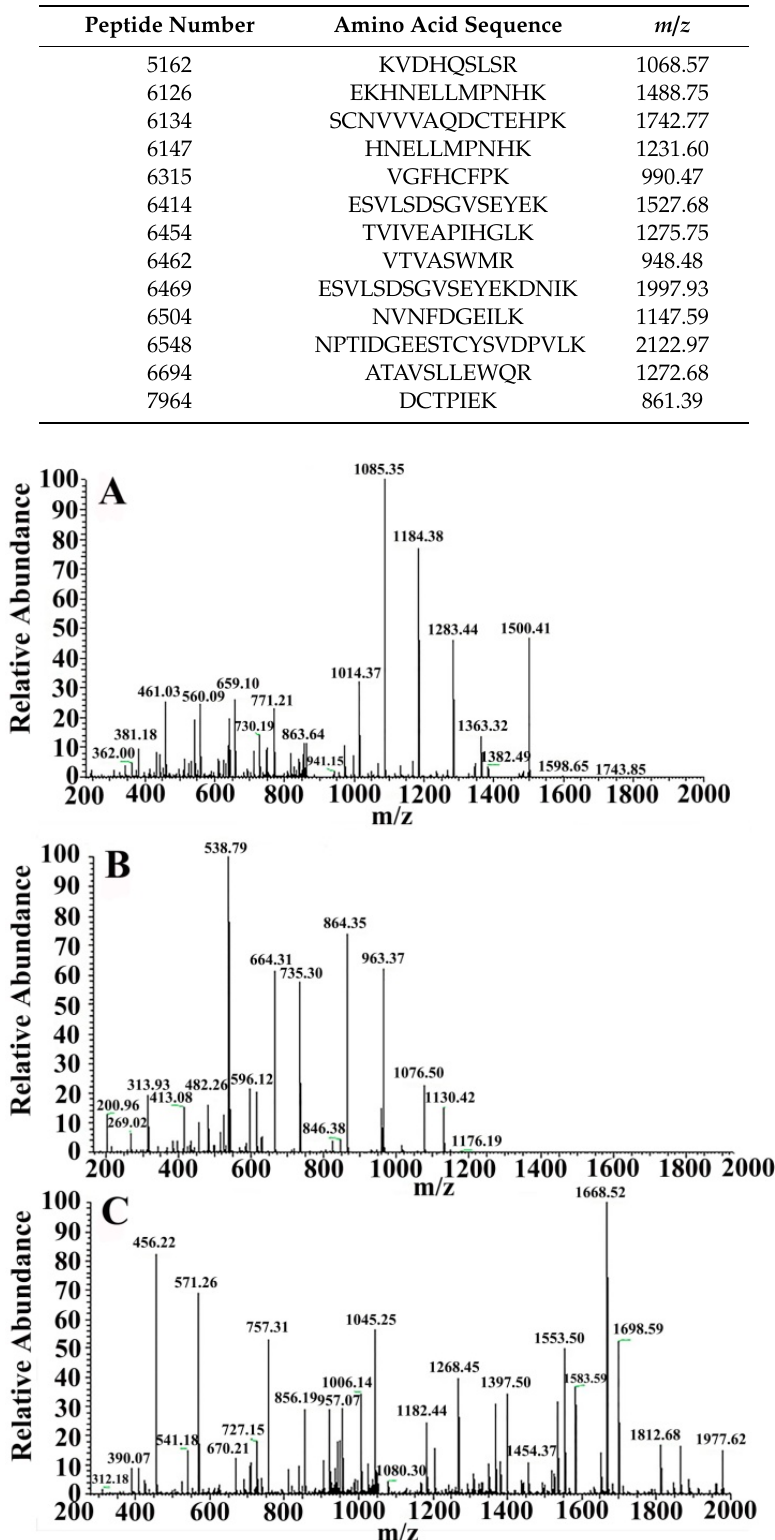
Figure 5. Two-level mass spectrometry of VIT1. ( A ) SCNVVVAQDCTEHPK; ( B ) TVIVEAPIHGLK; ( C ) NPTIDGEESTCYSVDPVLK.